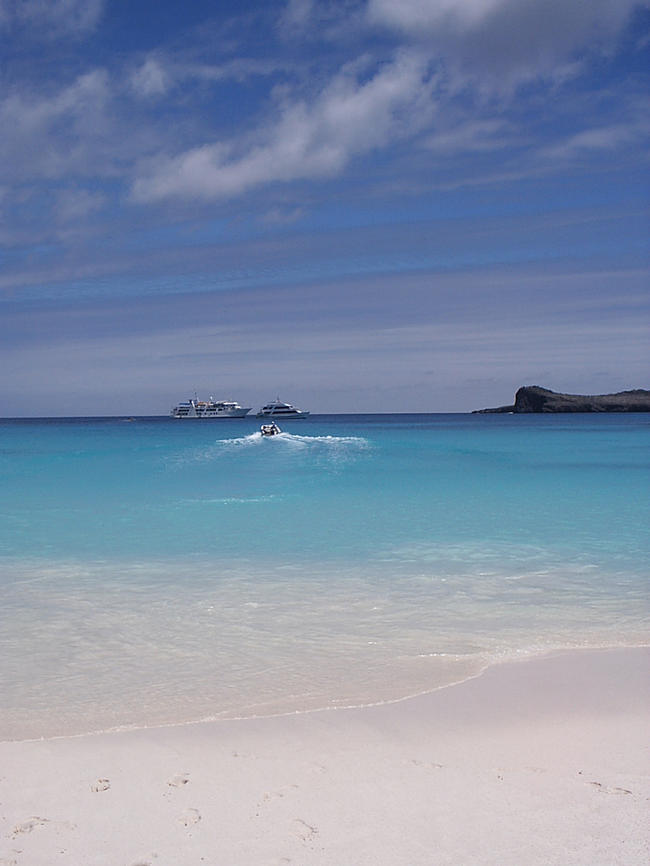
Ecotourist Paradise in the GalápagosCourtesy of Catriona MacCallum.